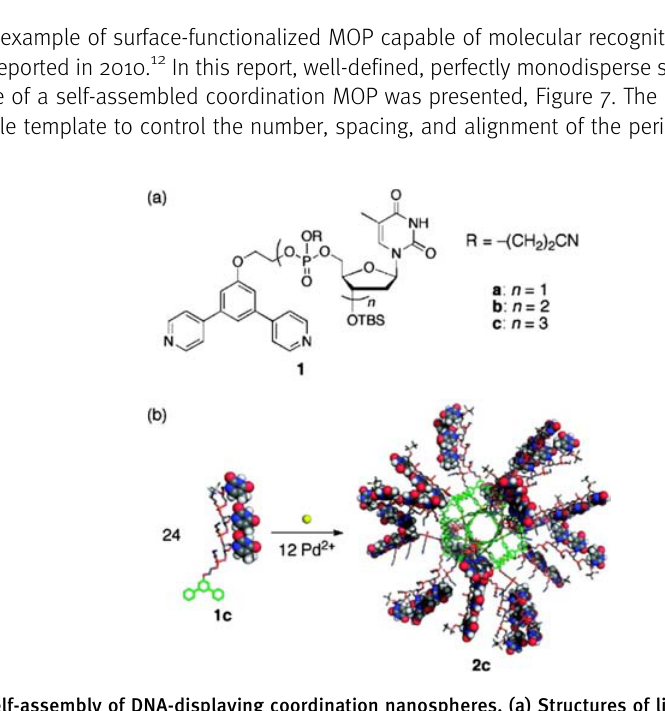
Figure 6. Turbidity changes, monitored by the absorbance at 500nm, on addition of MOPs 2a and 2b to (a) ConA. A large excess of (a) a -methyl mannopyranoside or (b) a -galactose was added as an inhibitor at 20min. Reprinted with permission from (N. Kamiya; M. Tominaga; S. Sato; M. Fujita. J. Am. Chem. Soc. 2007, 129 , 3816–3817). Copyright (2007) American Chemical Society.